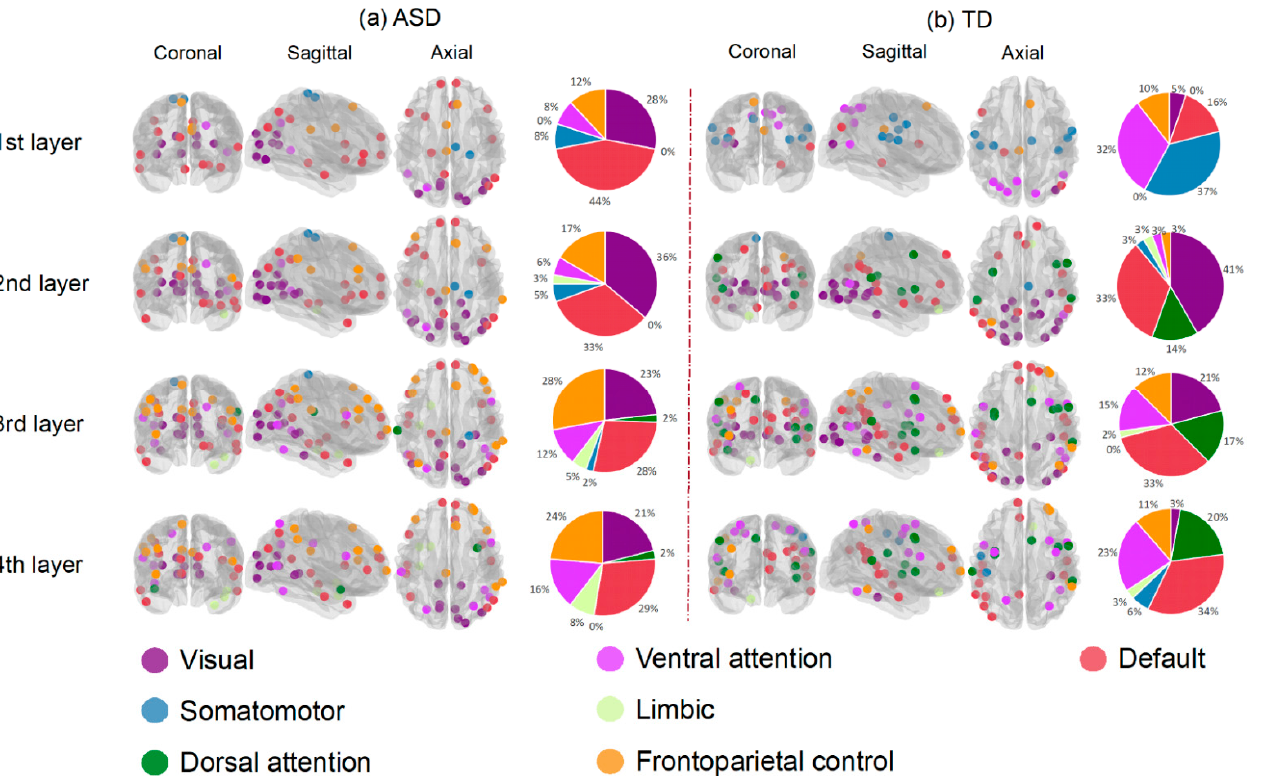
Figure 4. The salient ROIs for classifying ASD and TD in four hidden layers. The dots in the brain template represent salient ROIs in each layer of ( a ) ASD and ( b ) TD group. Different colors correspond to different functional networks. The pie charts showed the proportions of salient ROIs in 7-networks.